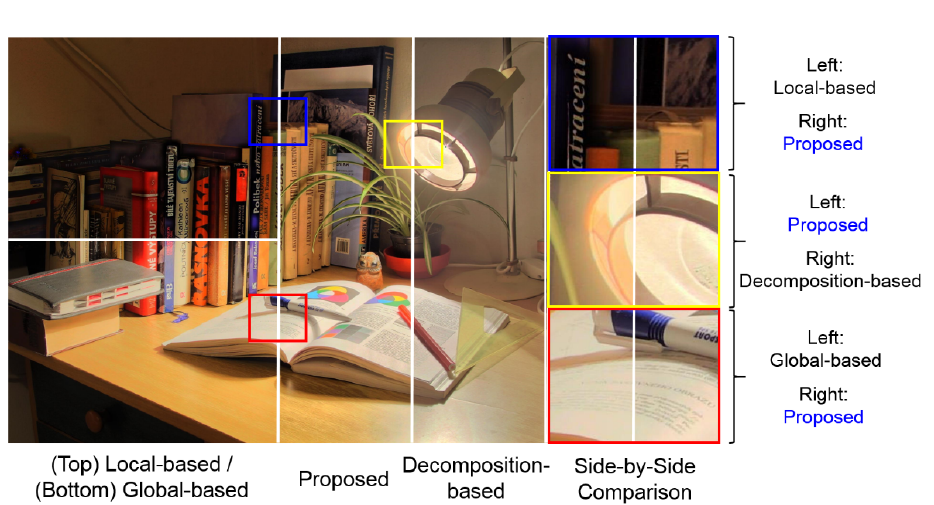
Figure 1. A rough comparison among a global-based reproduction method [8] ( bottom left ), a local-based reproduction method [9] ( top left ), a decomposition-based reproduction method [18] ( right ), and our proposed method ( middle ). This example shows that our method inherits the advantages of both global- and local-based reproduction method, while avoiding the unnaturalness issue of decomposition-based reproduction method (due to processing different layers separately.